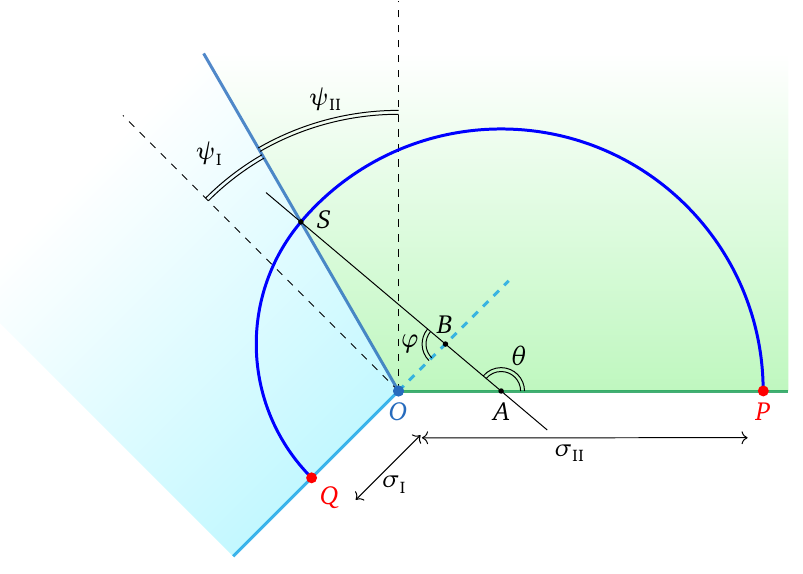
Figure 5: The smooth geodesic through the brane that connects two points on differ- ent CFTs which are respectively σ